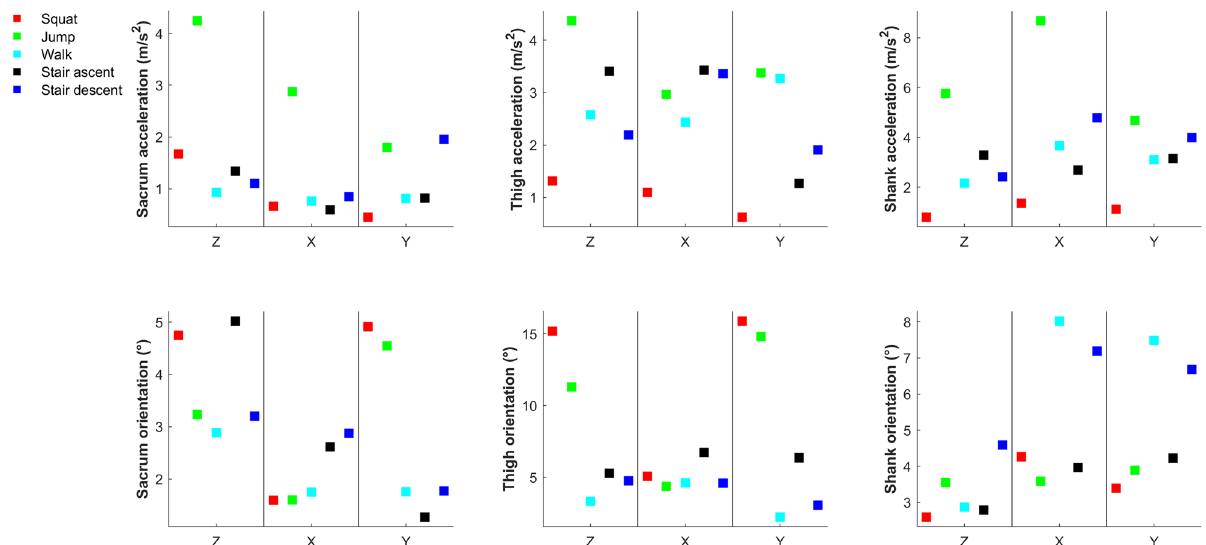
Figure 8. SEMs for acceleration and orientation range values (session 1 vs. session